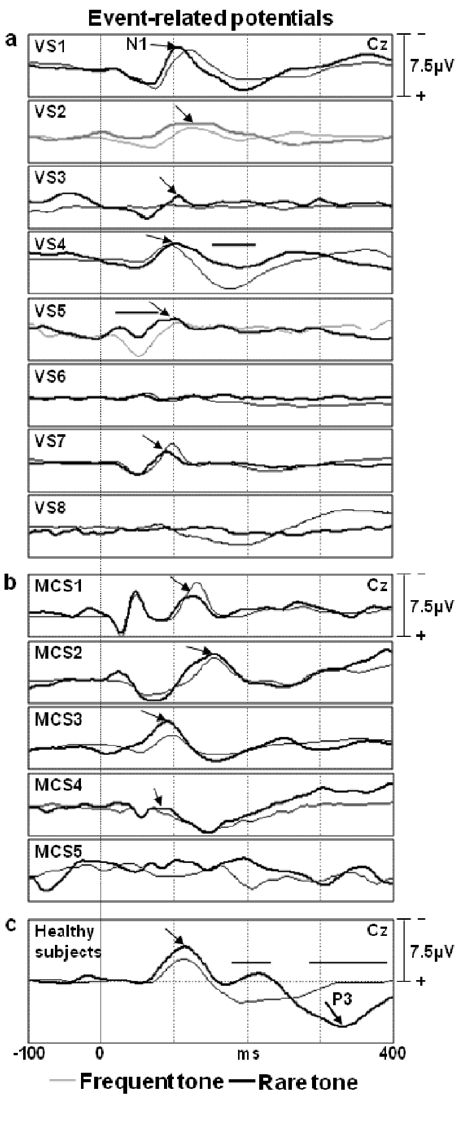
Figure 4. Individual event-related potentials (ERPs) recorded from the Cz electrode to frequent (thin line) and rare (thick line) tones. Panel a : vegetative patients (VS). Panel b : minimally conscious patients (MCS). Panel c : normal control subjects (grand average of 25 individuals). Horizontal segments refer to the time windows where the ERP responses to frequent and rare tones differed significantly (sample-by-sample t-test, p , 0.01).